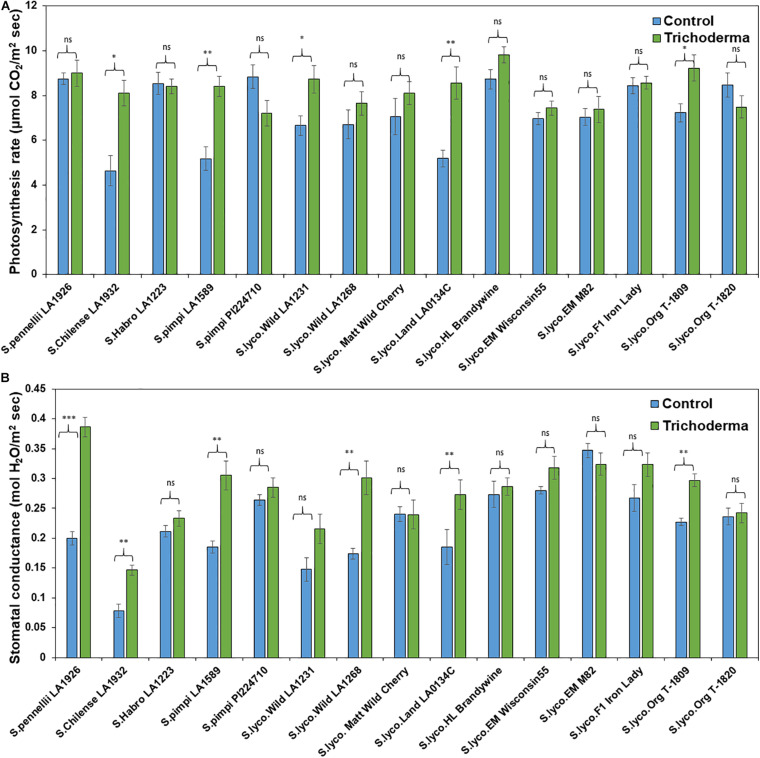
Effects of Trichoderma treatment on (A) photosynthesis and (B) stomatal conductance in a set of diverse tomato genotypes. Asterisks indicate significant differences in photosynthesis and stomatal conductance in the Trichoderma-treated versus control plants using the Student’s t-test at a ∗P ≤ 0.05, ∗∗P ≤ 0.01 and ∗∗∗P ≤ 0.001. Bars represent the standard error.